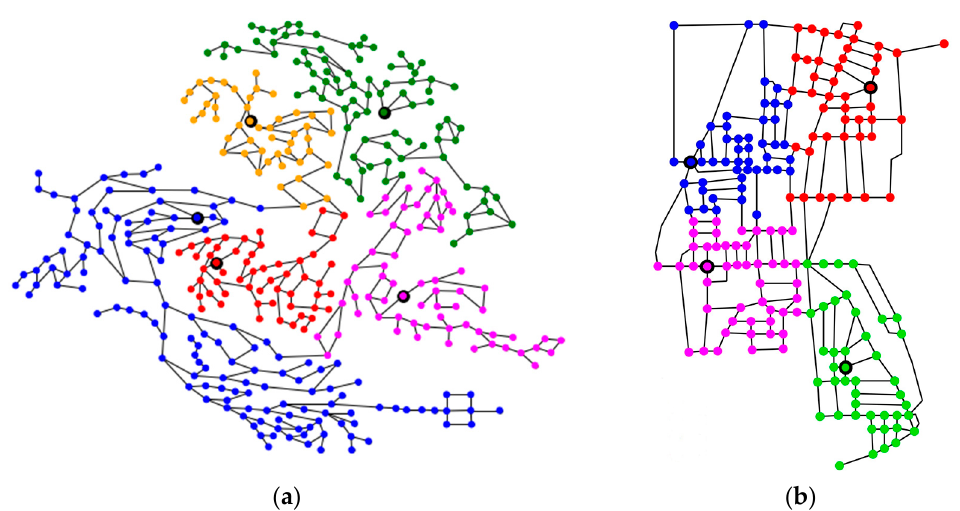
Figure 8. Optimal clustering layout for the two case studies with different colors for each clusters and highlighting the most important nodes of each cluster according to the eigenvector centrality of the partitioned networks: ( a ) C-Town network ( k = 5) and ( b ) Parete network ( k = 4).